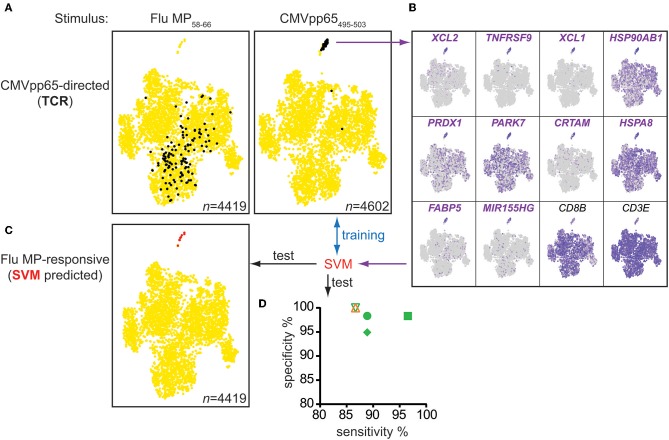
Multimer-independent identification of antigen-responsive cells from bulk memory CD8+ T cells. (A) t-SNE plots of gene expression data from CD95+CD8+ memory cells sorted from the PBMCs of donor #4 incubated for 20 h with the indicated peptides. Cells expressing CMVpp65495−503-directed TCRs, known from previous CMV multimer-based experiments, are shown in black. (B) t-SNE plots for CMV peptide-stimulated cells in (A) showing the expression levels of the top 10 genes marking the cluster of antigen-responsive cells and of the reference genes CD3E and CD8B. The 10 genes were used to train a machine learning algorithm (SVM), which was subsequently tested for its sensitivity and specificity to distinguish antigen-responsive cells from control stimulated-cells in the scRNAseq data sets of donors #4–6 (CMV-directed) and # 1 (Flu-directed) (D) and to predict Flu MP58−66-responsive cells from bulk memory CD95+CD8+ T cells (C).